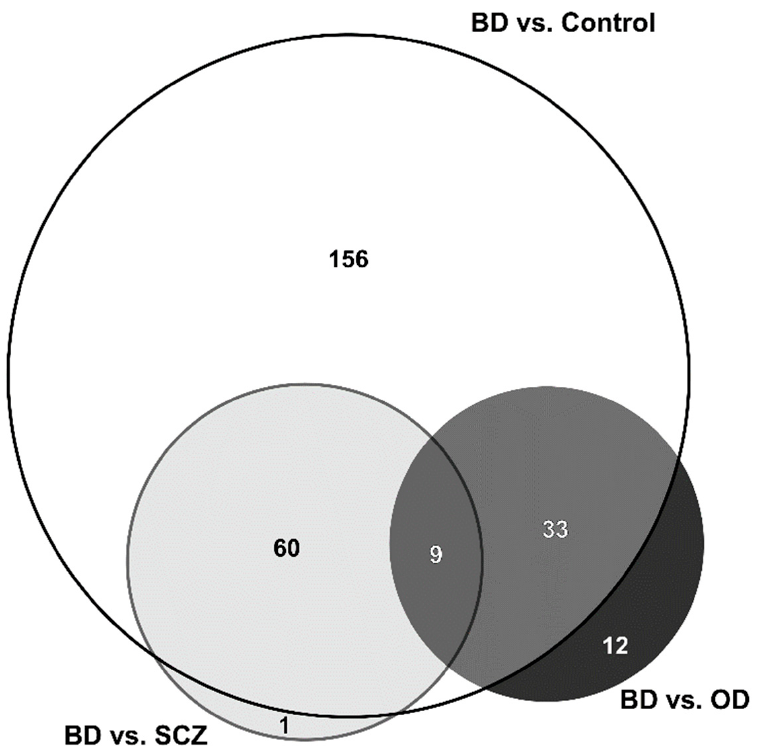
Figure 3. Venn diagram of proteins identified as altered in BD in the selected studies (BD vs. control, BD vs. SCZ, and BD vs. OD; see text for details).